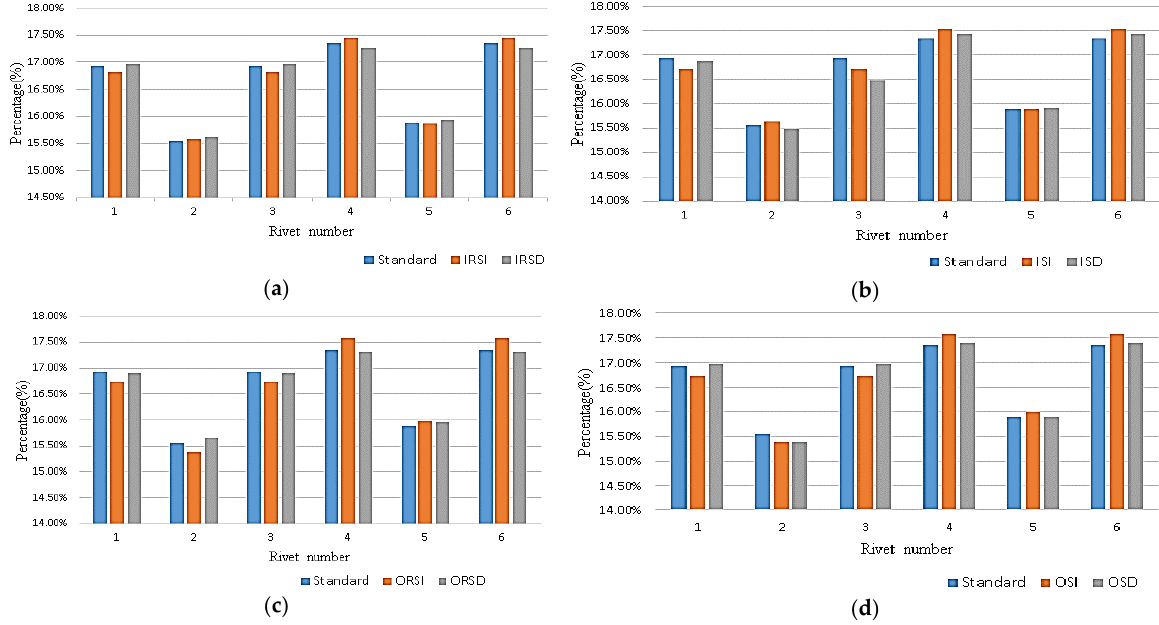
Figure 15. Nail loading ratio of different rivet layouts: ( a ) the nail load ratio after changing the inner row spacing; ( b ) the nail load ratio after changing the inner spacing; ( c ) the nail load ratio after changing the outer row spacing; ( d ) the nail load ratio after changing the outer spacing.